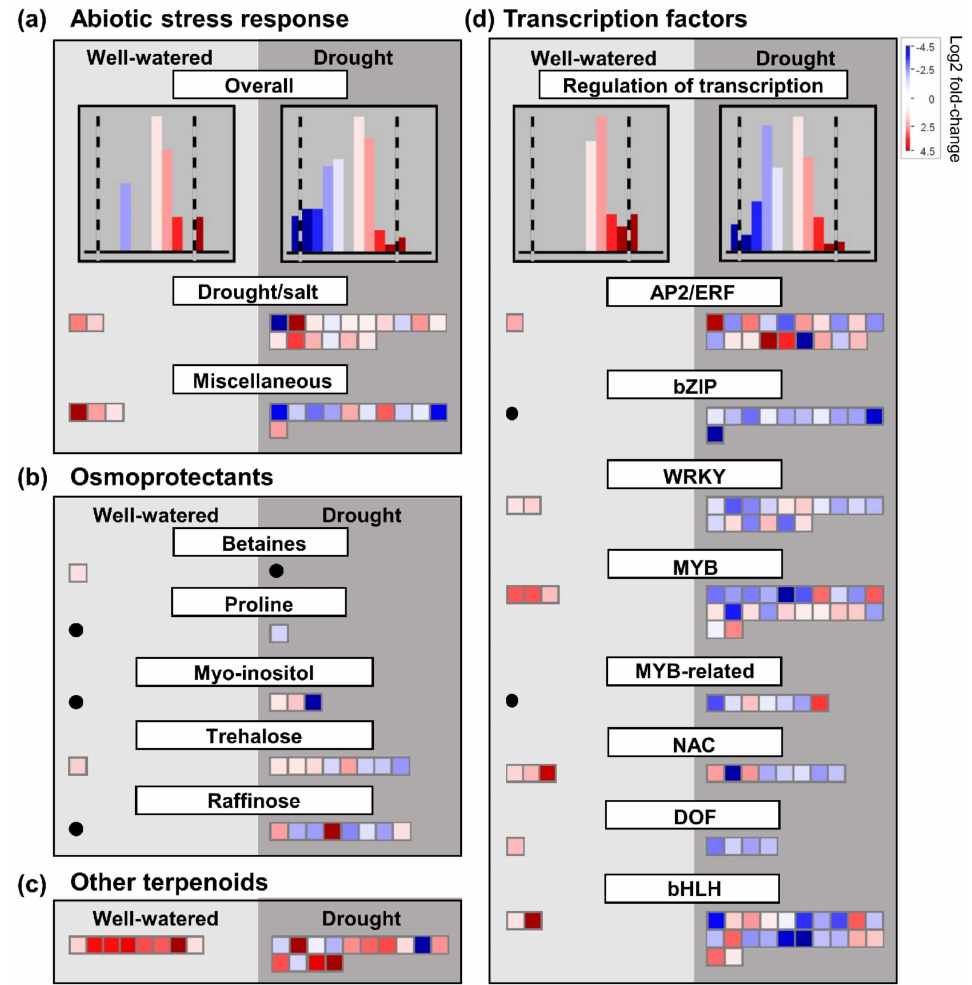
Figure 5. Transcriptional alterations in abiotic stress-related metabolic pathways and transcription factor families between ‘sativa’ and ‘falcata’ under both control and drought conditions. Pathway analysis was conducted using MapMan, with blue boxes indicating down-regulated genes and red boxes denoting up-regulated genes. Pathways shown include those related to ( a ) abiotic stress response, ( b ) the metabolism of various osmoprotectants, ( c ) the metabolism of non-tocopherol and non-carotenoid terpenoids, and ( d ) a selection of transcription factor